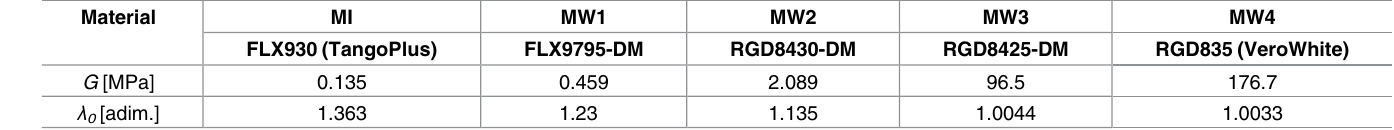
Table 1. Shear modulus G (in the dry state) and stretch ratio λ 0 upon swelling in isopropanol of 3D printed polymers.